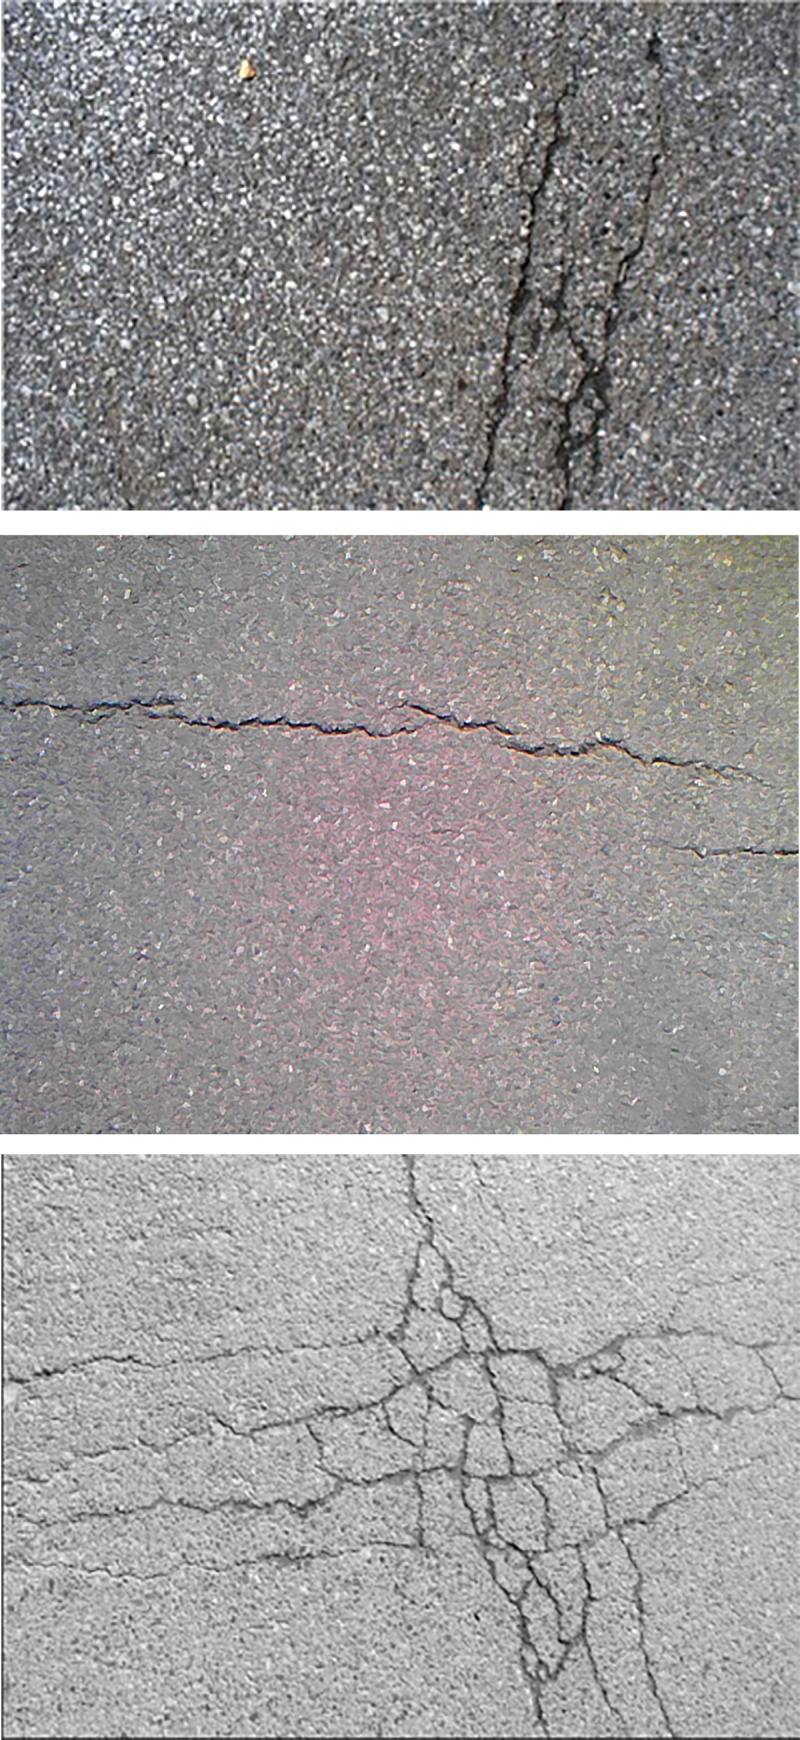
Typical collected pavement crack images.